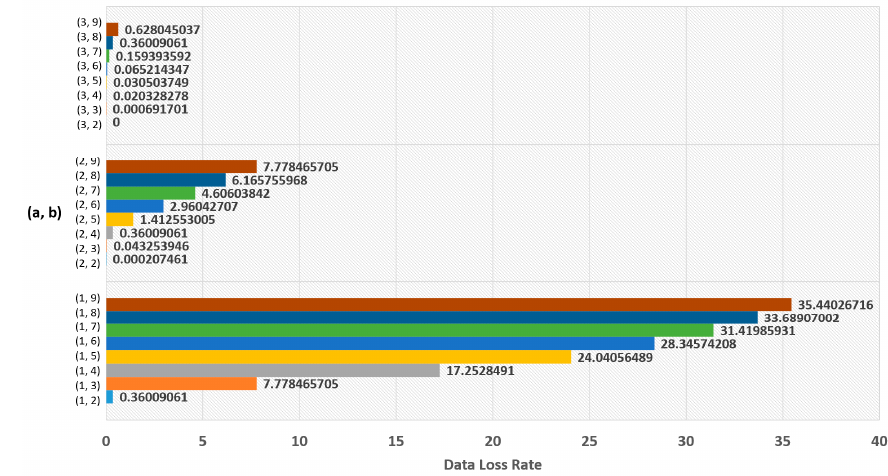
Figure 11. Network lifetime in case of using logarithmic function.